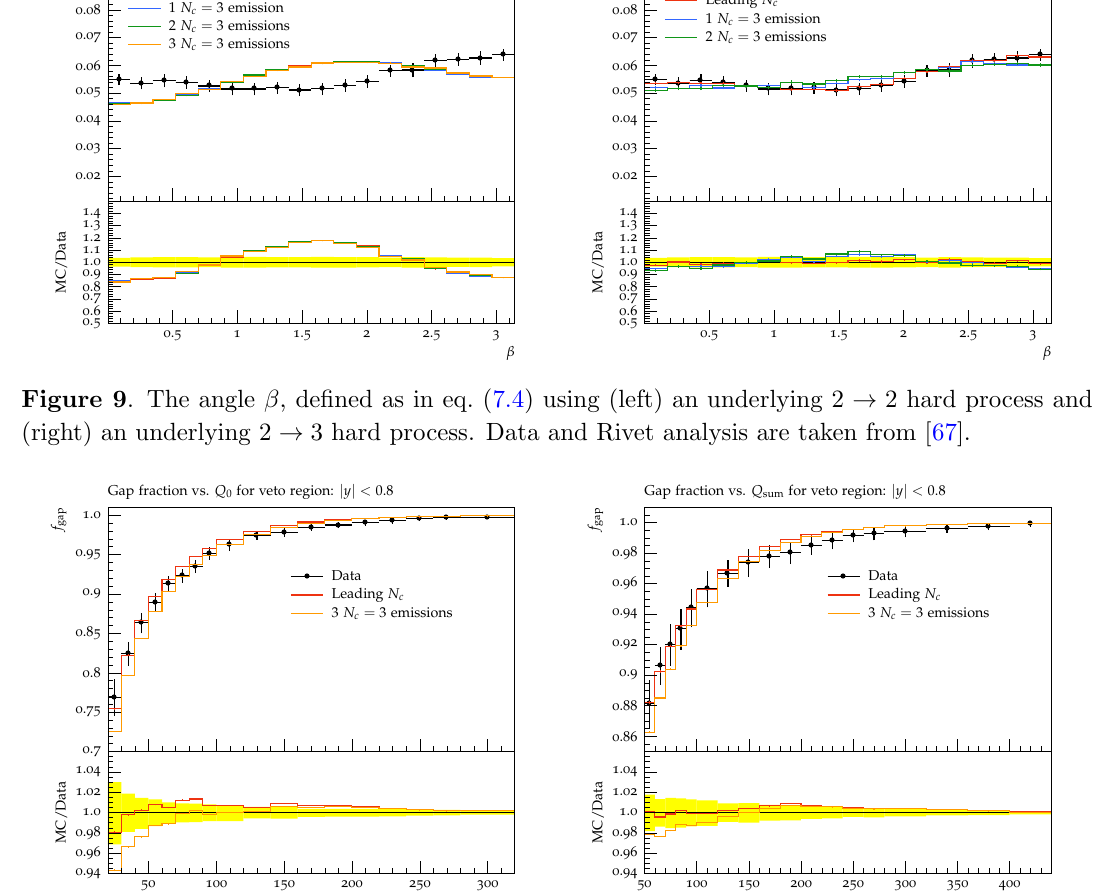
Figure 10 . Fraction of events having no additional jet with p ? above Q 0 within a rapidity interval y < 0 : 8 (left) and fraction of events where the scalar sum of transverse momenta within j j does not exceed Q sum (right) for tt events at p s = 7 TeV. Data and Rivet analysis are taken from